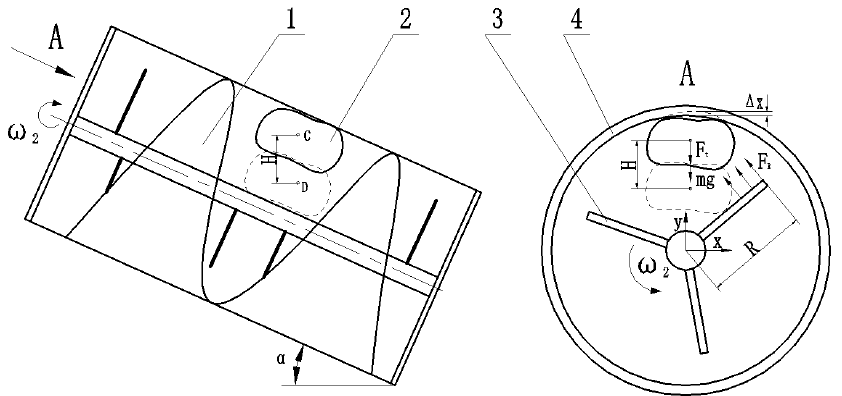
Figure 5. Dynamic analysis of radial collision in fruit–soil separation. 1. Spiral conveyor blade; 2. Massive soil; 3. Broken soil roller; 4. Rigid ring. ( A represents the view direction; R is the length of the flexible roll finger, mm; ω 2 is the rotational angular velocity of the fruit–soil separator; rad/s; H is the height at which the large clods fall, mm; α is the tilt angle of the fruit–soil separation unit, (°); m is the mass of bulk soil, kg; F t is the spring force of the elastic rope, N; Δ x is the elasticity of the elastic rope shape variables, mm; F R is the effect of large clods breaking, N).